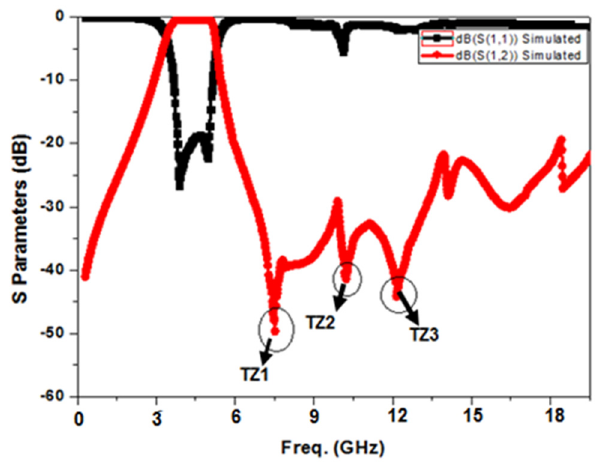
Figure 12. Simulated frequency response of the proposed BPF.